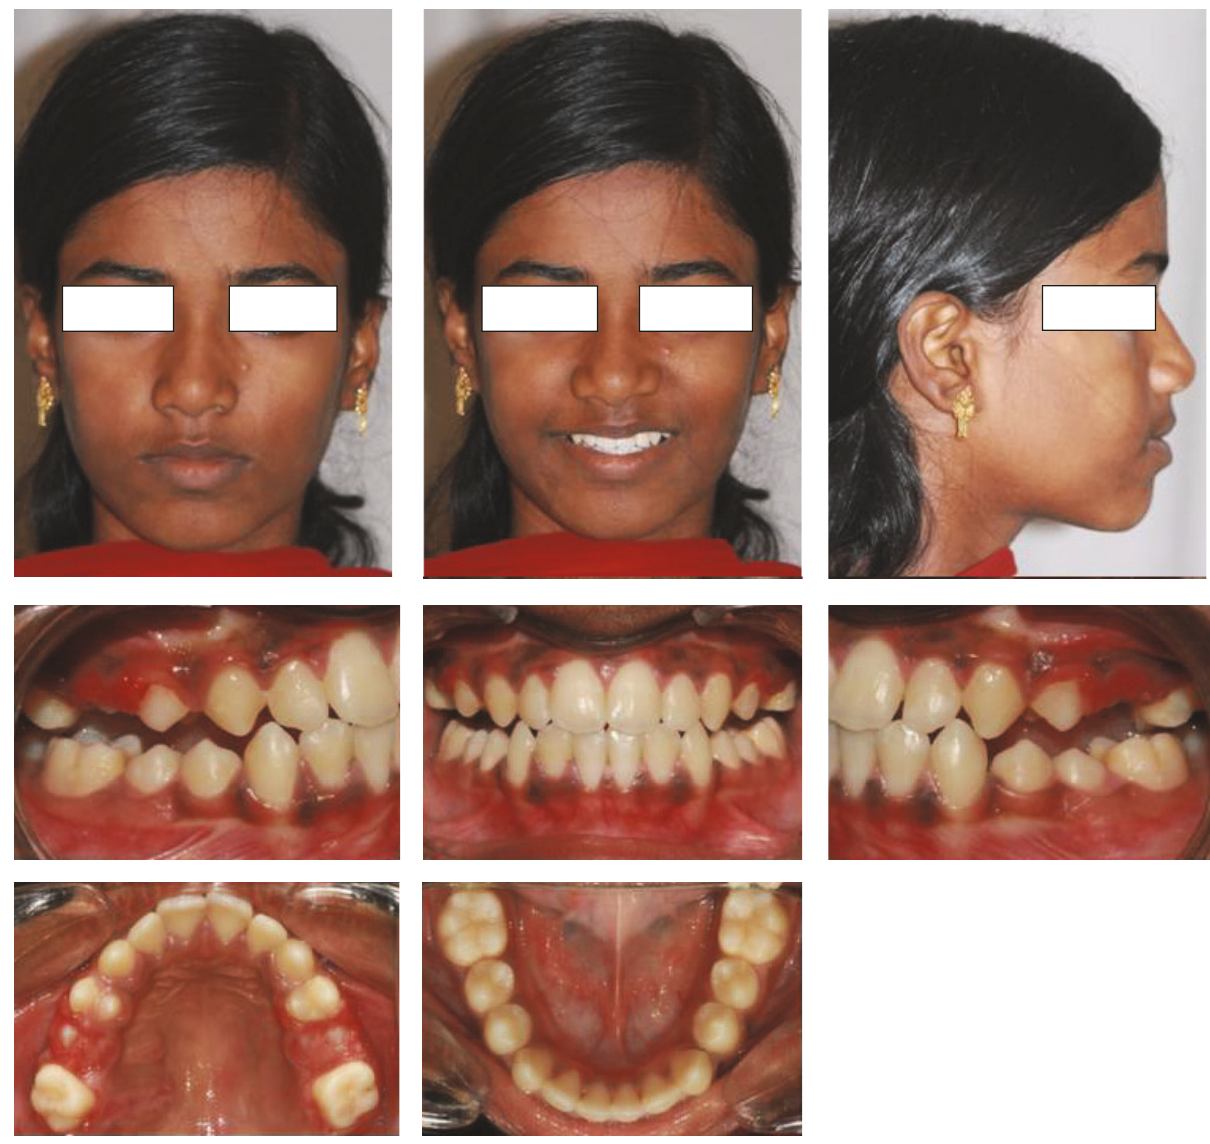
Figure 4: After facemask therapy.